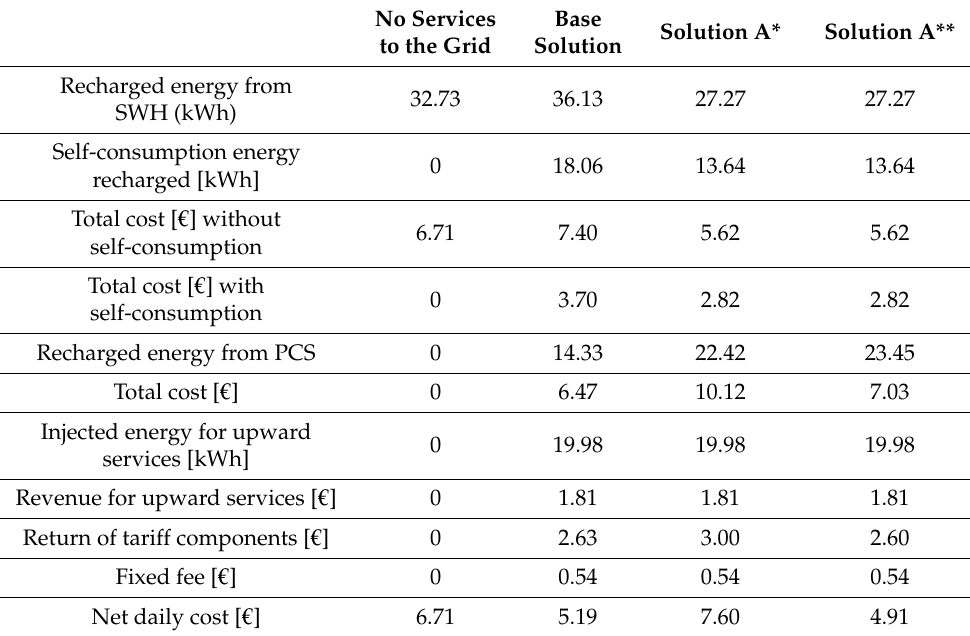
Table 29. Results for mobility pattern 2—UVAM (Scenario C).